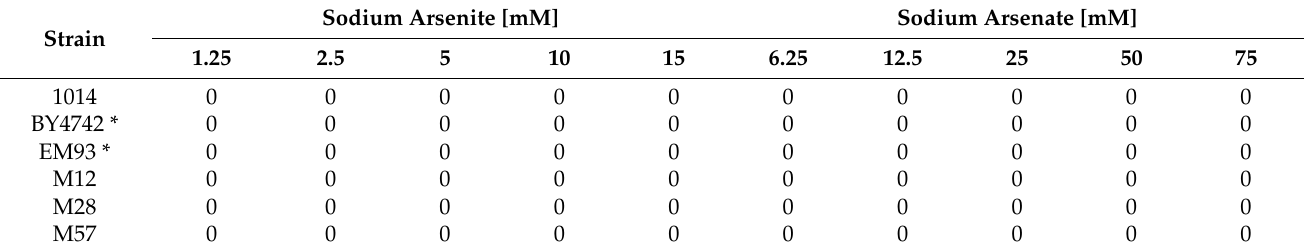
Table 1. Growth of Saccharomyces cerevisiae cells (laboratory strains and strains from vineyard-related specimens) in the presence of sodium arsenite and sodium arsenate. Cells (10 3 ) of each strain were spotted onto YPD medium supplemented with the reported sodium arsenate or sodium arsenite concentrations. Growth was scored after four days incubation at 30 ◦ C as follows: 0—no